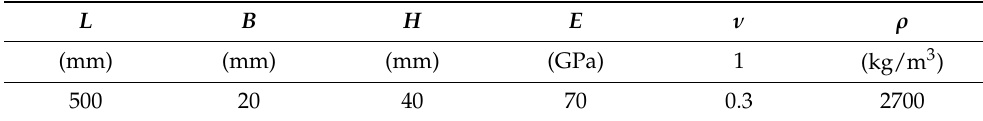
Figure 1. Geometry sketch of a cantilever beam with a breathing crack. Table 1. Parameters of the cantilever beam model.